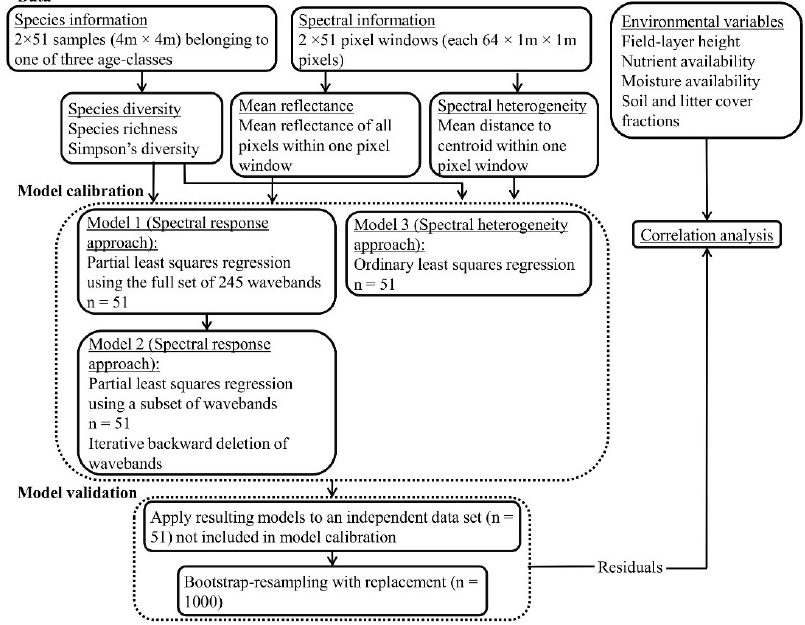
Figure 2. Schematic overview of the workflow used in the present